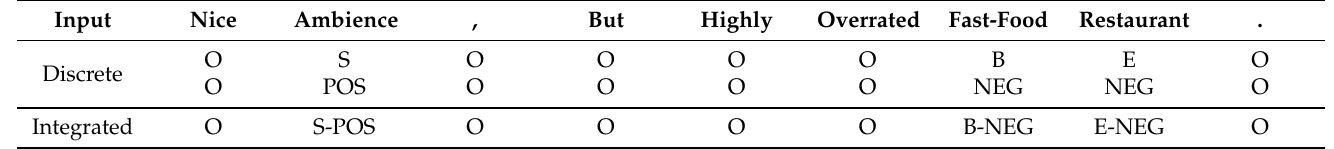
Table 1. The discrete tagging approach and integrated tagging approach. “Discrete” and “Integrated” refers to these two tagging schemes,